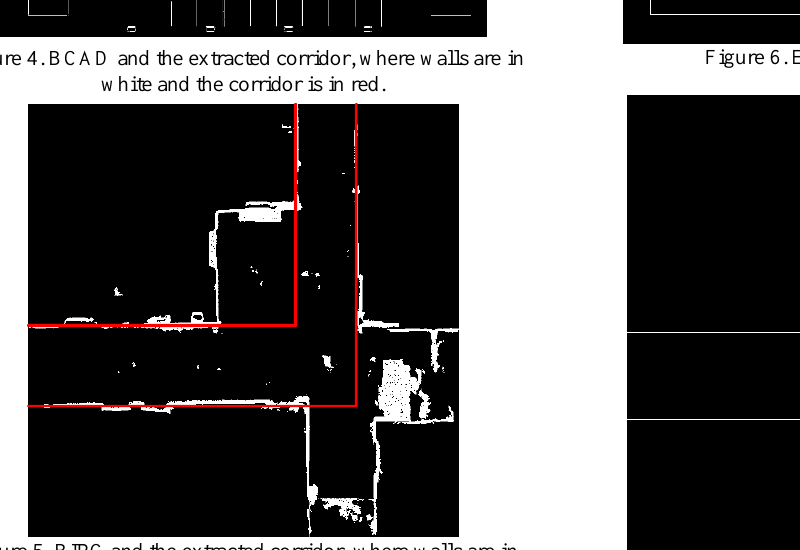
Figure 7. Extracted points in BIPC